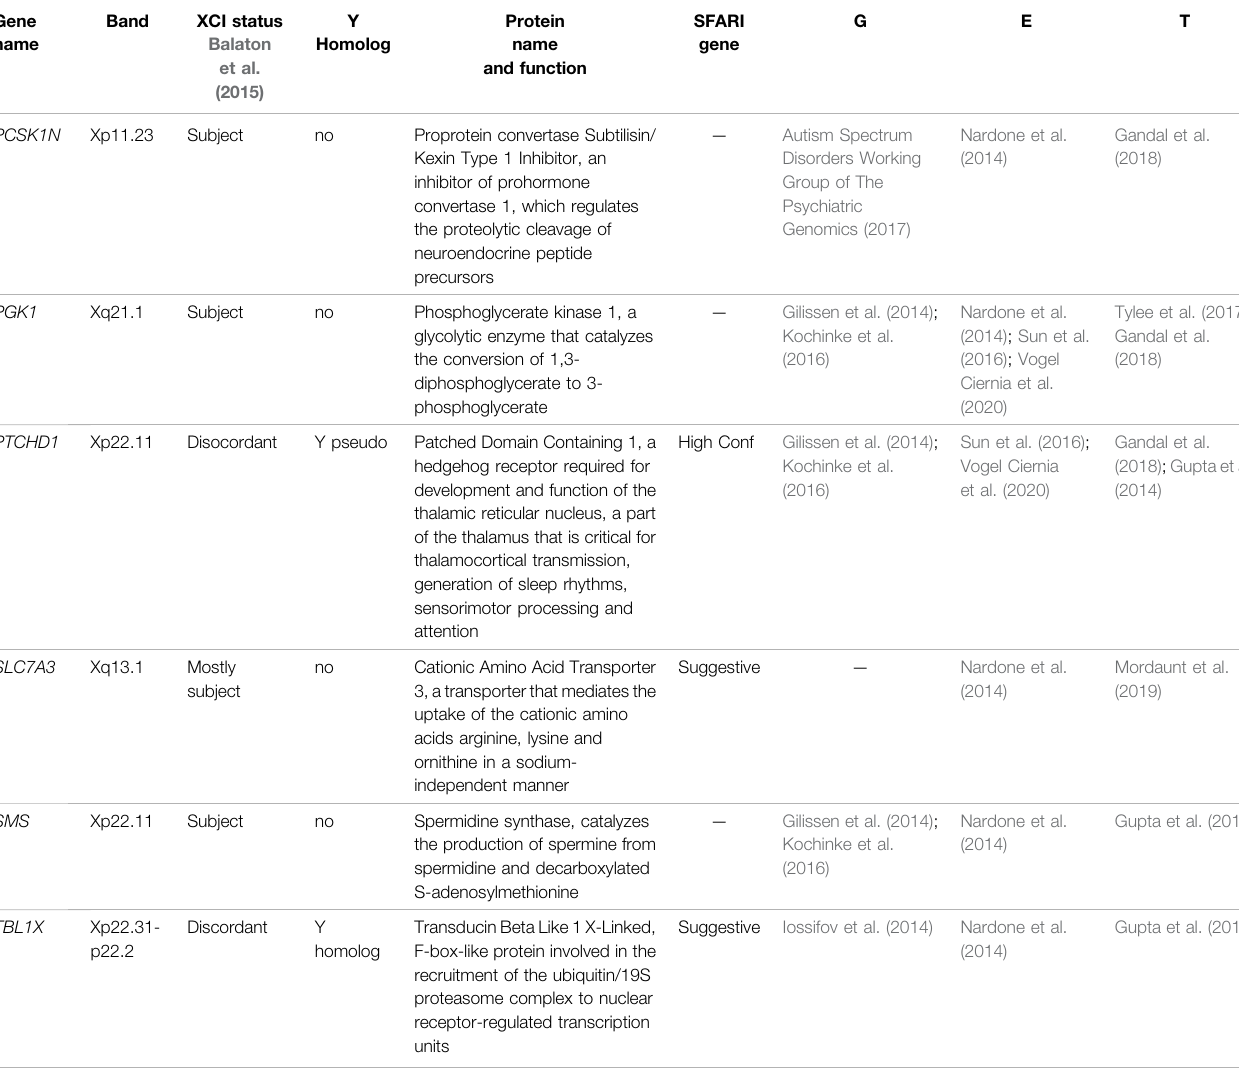
implantation. In Figure 1 , I revisit the question of whether the enrichment of X-linked genes we identi fi ed in ASD cord blood, a tissue derived from the epiblast lineage, could be related to their variable cellular expression and XCI status at a stage closer to post-implantation in humans. For this, the transcripts XACT , XIST , and two ASD relevant genes from Table 1 , PTCHD1 and MID1 , were plotted from a recent single cell RNAseq data set from 16 human embryos cultured to 9 or 11 days post fertilization, bioinformatically sorted into epiblast, hypoblast, syncytiotrophoblast, and cytotrophoblast (www.humanembryo.org) (Mole et al., 2021). Interestingly, among the cell type markers